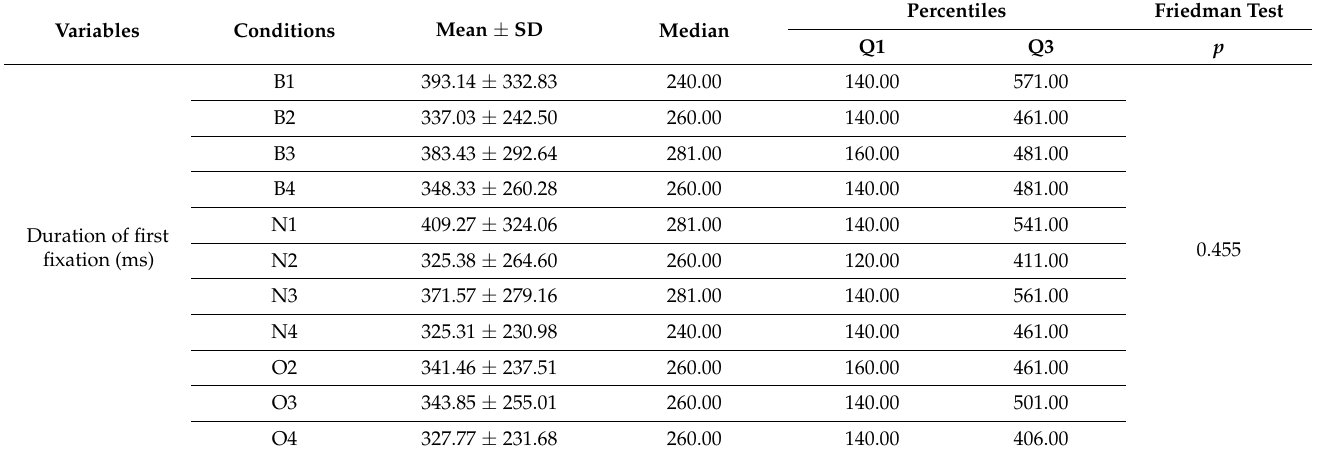
Table 2. Descriptive statistics (mean ± standard deviation, median, Q1 and Q3) and Friedman test values for all variables (time of first fixations, number of fixations, and total time of fixations) for the sample (n =